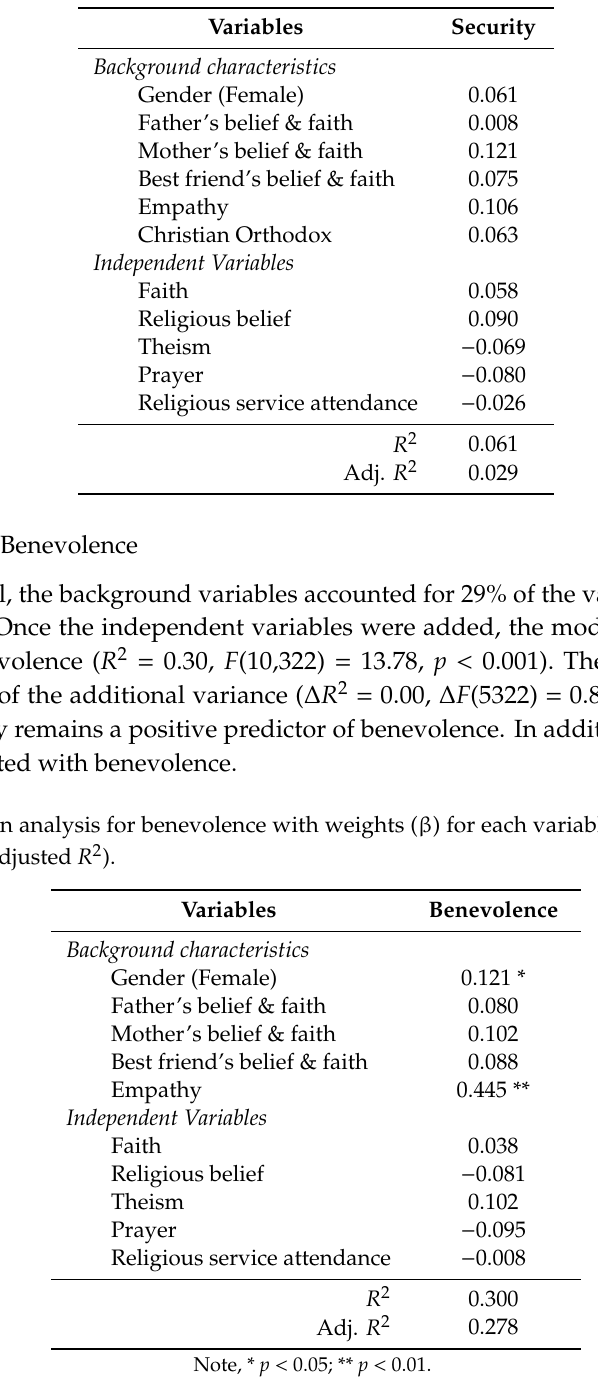
Table 3. Regression analysis for security with weights ( β ) for each variable and total explained variance ( R 2 and adjusted R 2 ).